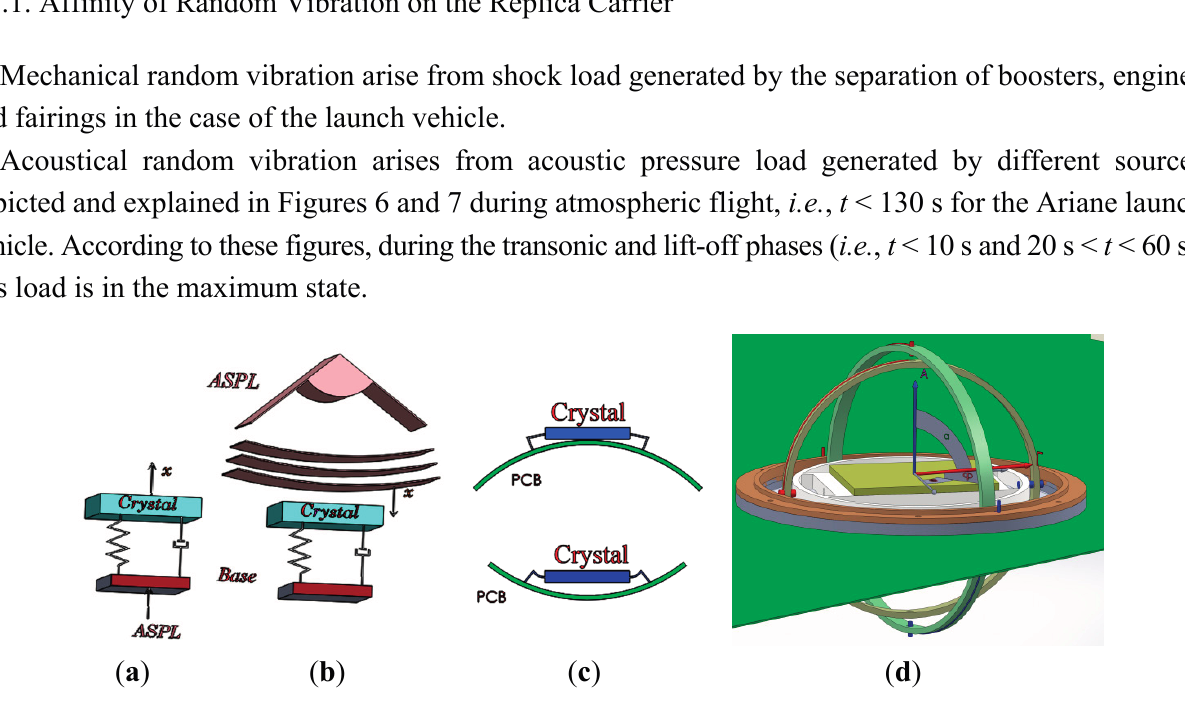
Figure 14. Acoustic load applied on the crystal ( a ) as the mechanical random vibration from the base and ( b ) as the acoustical random vibration directly on the surface; ( c ) the effect of flexible connectors on transferring random vibration from the base; ( d ) The isolator (LPF) between main ring of the gyroscopic mounting and the